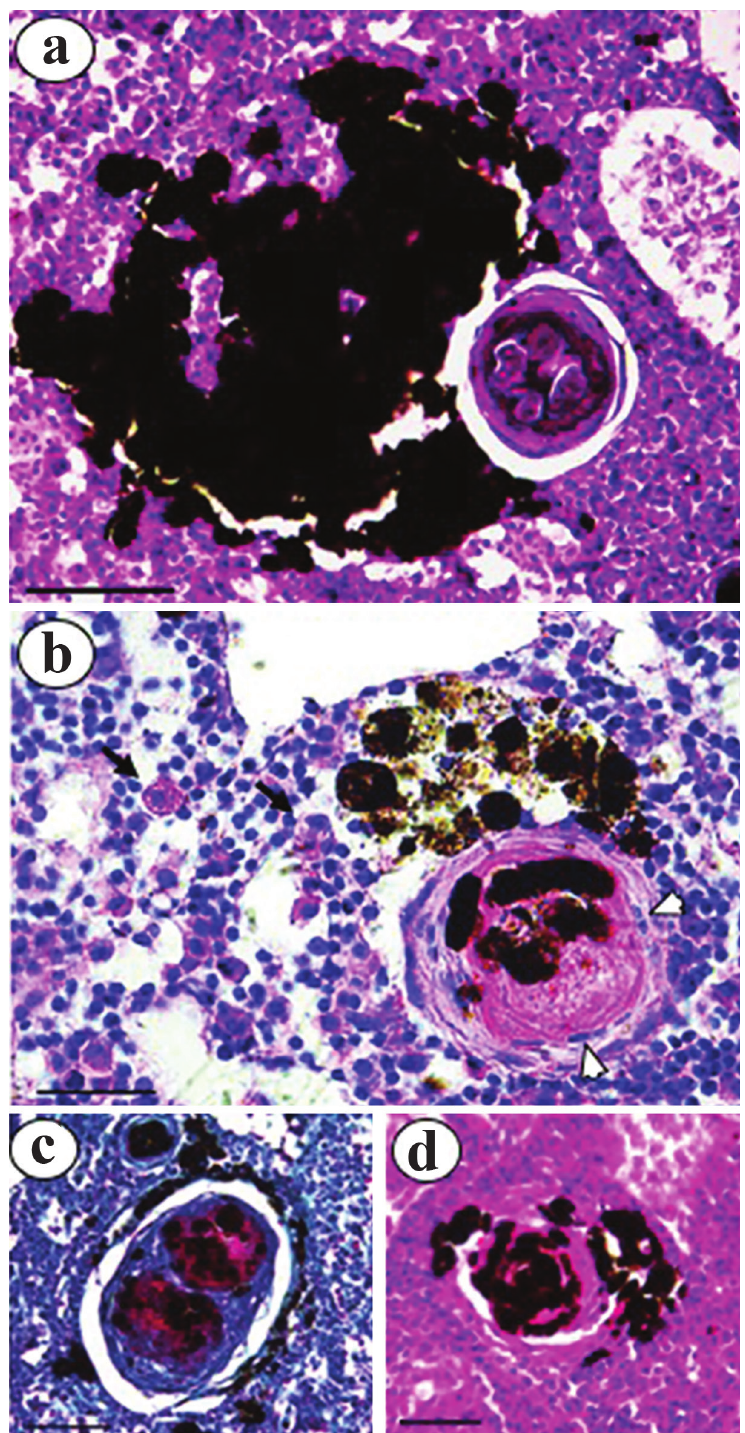
Fig. 4. Histological cross-sections of the head and exocrine kidney demonstrating different granulomatous structures in Gymnotus inaequilabiatus . a. severe aggregation of MMCs outer to granuloma in the exocrine kidney; PAS, bar scale = 20 µm. b. a clump of melanogenic macrophages (dark pigmented cells) adjacent to granuloma in the head kidney. The hematopoietic tissue is edematous and atypical. Some rodlet cells (black arrow) are observed. Granuloma presents a compact and thick layer of collagen with internal necrotic content surrounded by epithelioid cells (white arrows); H&E, bar scale = 10 µm. c. two well-defined granulomas with substantial internal necrotic content involved by fibrous tissue. A slight layer of MMCs aggregates close to the external wall of granuloma. TM, bar scale = 10 µm. d. MMCs aggregates both internally and externally to granuloma in the exocrine kidney. HE, bar scale = 10